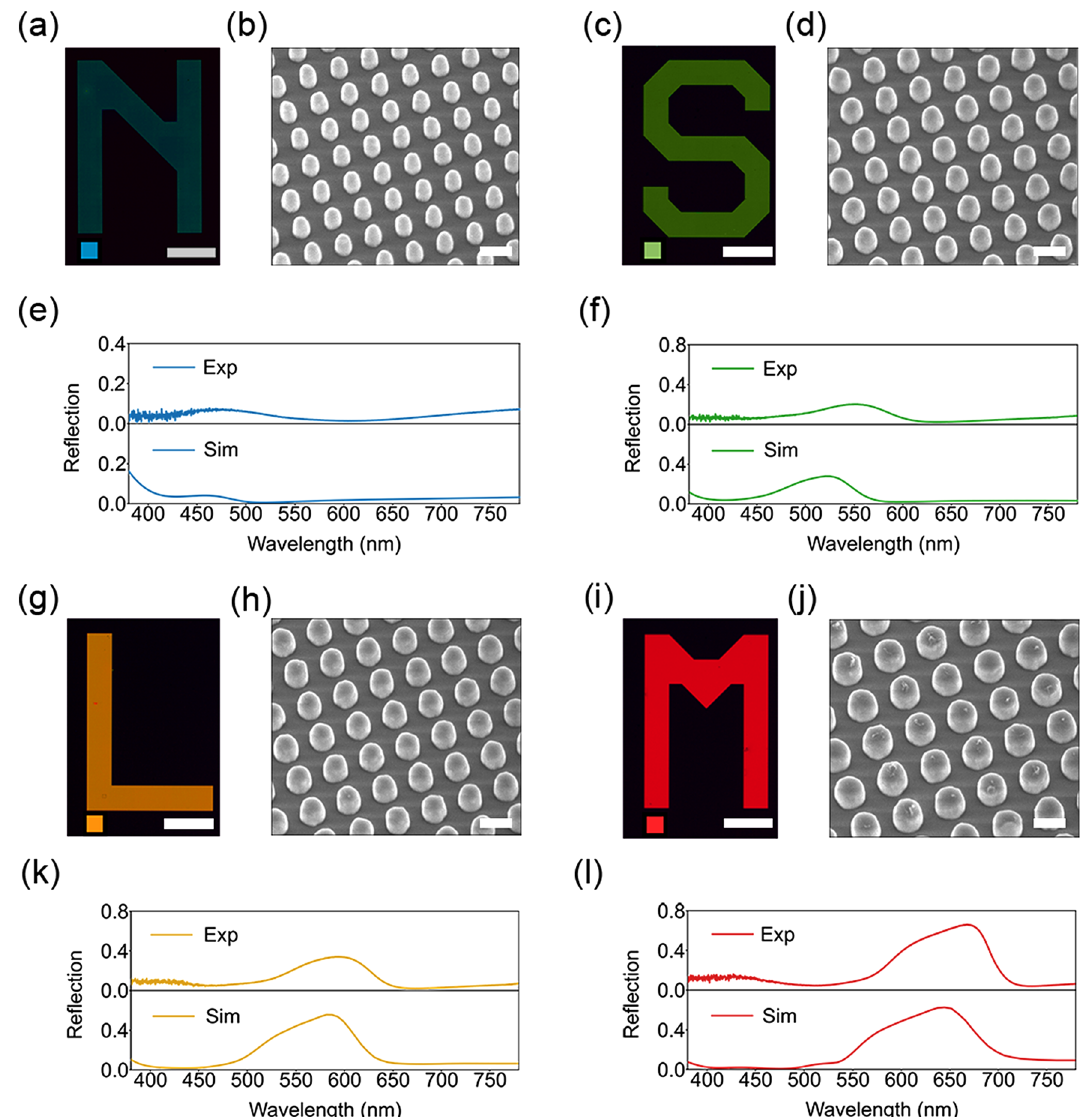
Figure 3. Microscope images of selected colors ( a , c , g , i ) with corresponding tilted-view SEM images of the nanostructures comprising each letter ( b , d , h , j ). The scale bars in the microscope images correspond to 200 µ m, scale bars in the SEM images are 200 nm. The square color patches shown as insets in the bottom- left corners of the microscope images denote the target simulated colors. ( e , f , k , l ) show corresponding experimental (top) and simulated (bottom) reflection spectra for each of the